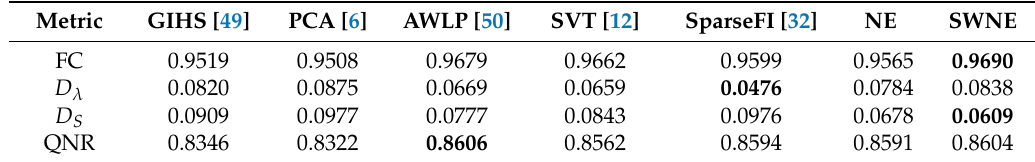
Table 3. Numerical results of each fused image shown in Figure 1.